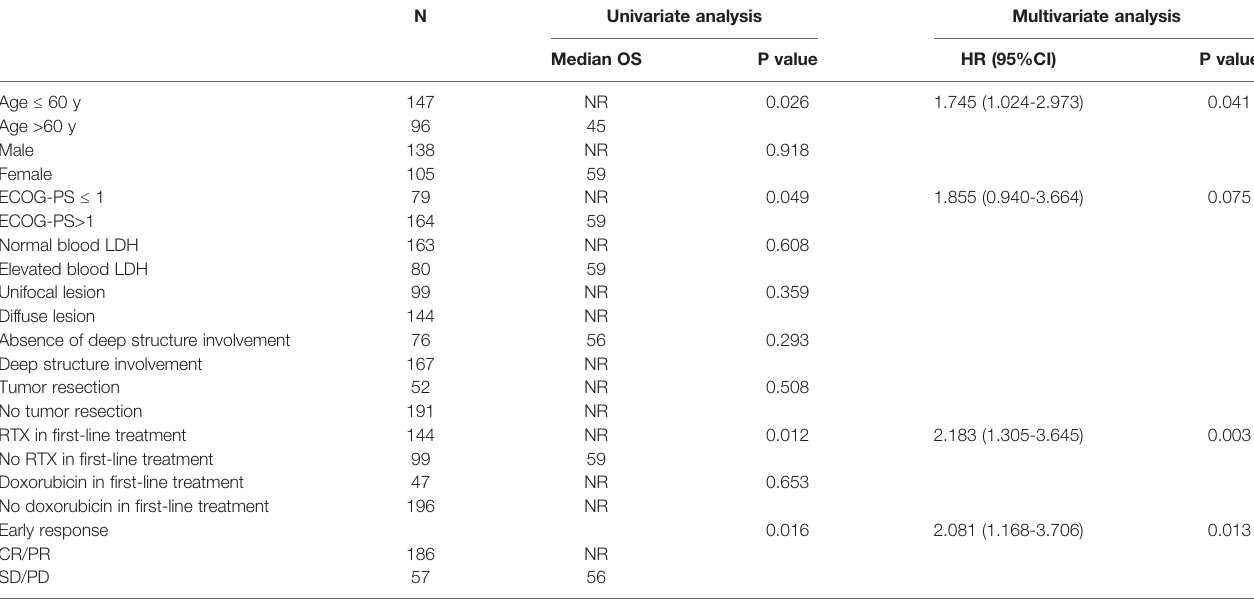
TABLE 4 | Univariate and multivariate analyses of OS. N Univariate analysis Multivariate